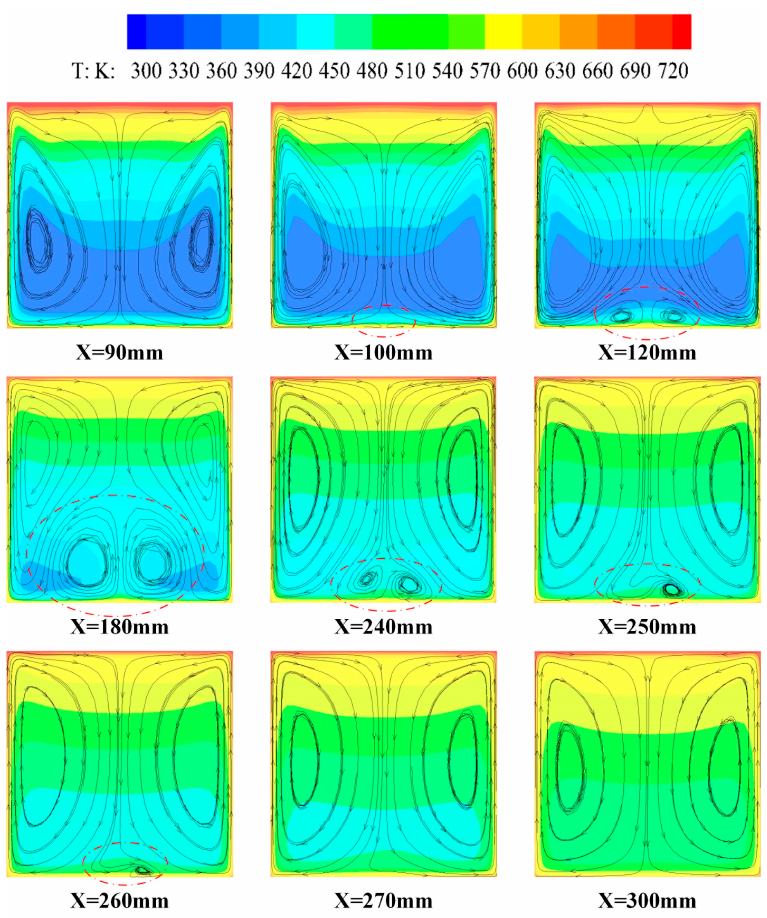
Figure 13. Streamlines of cross section along the flow direction in case C.